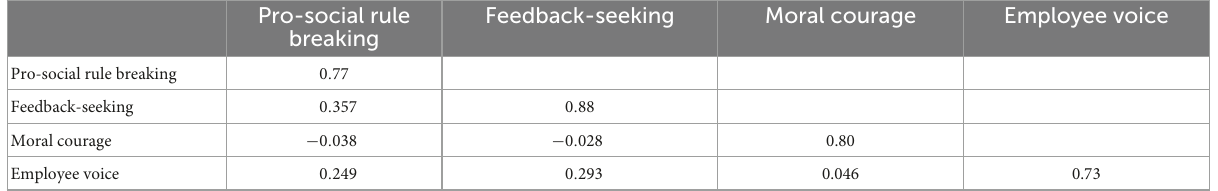
TABLE 4 Correlation and the square roots of AVEs.